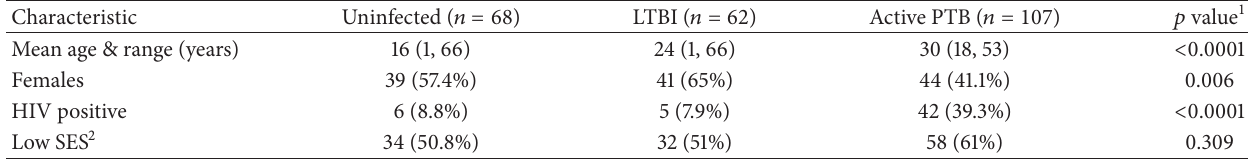
Table 1: Study participant characteristics.